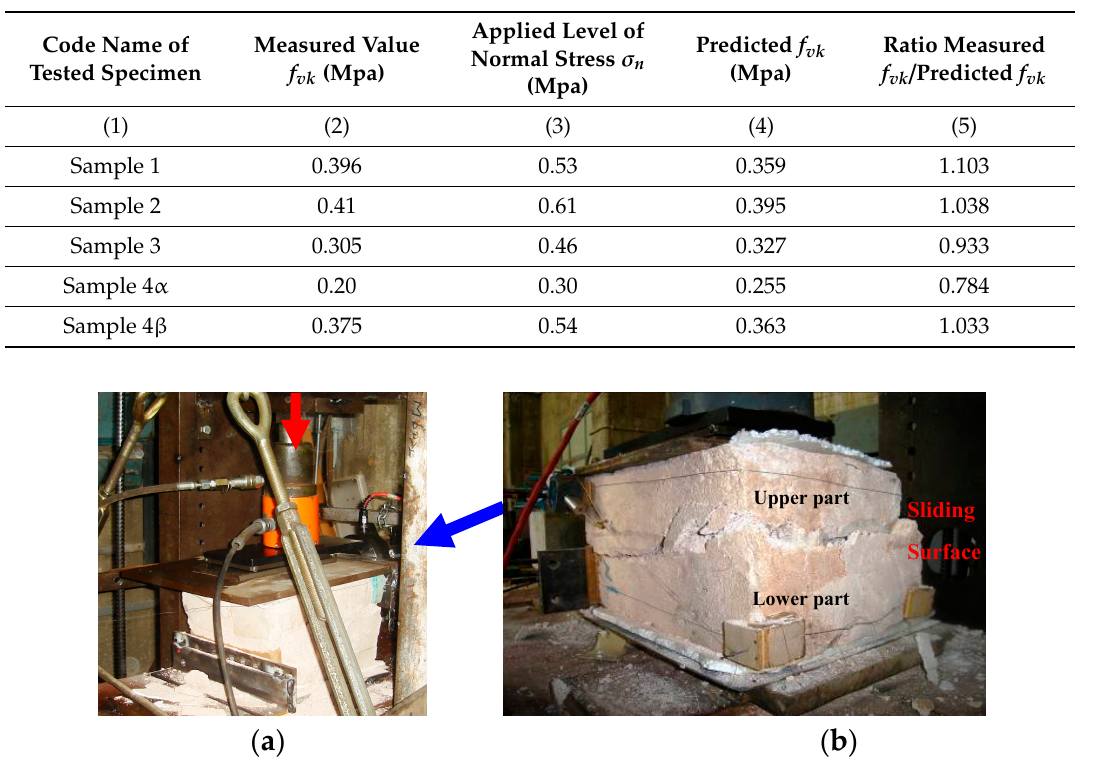
Table 1. Comparison between measured and predicted shear strength values.